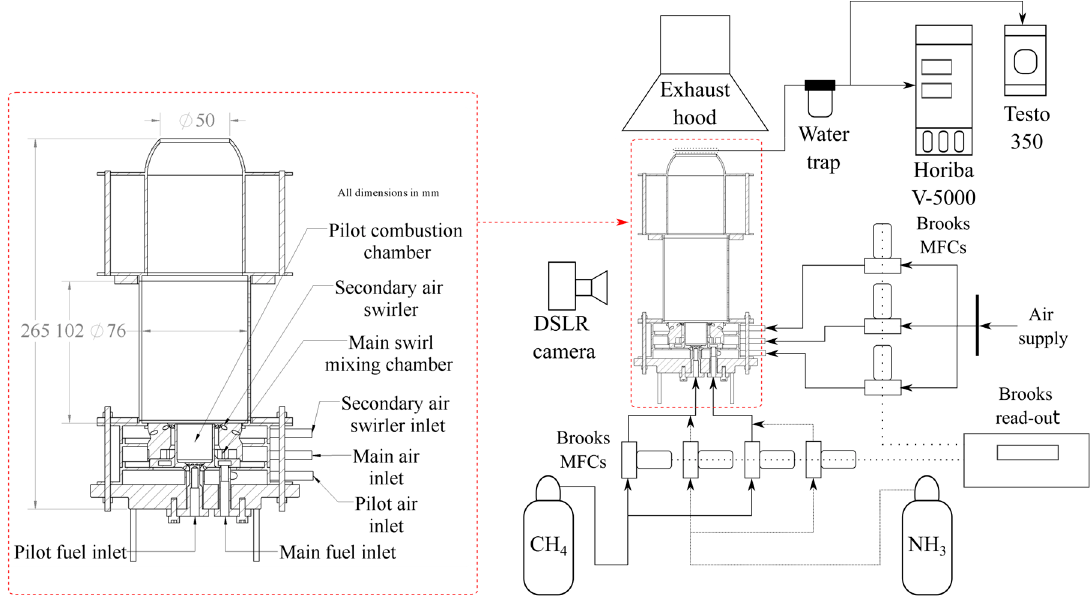
Figure 1. Schematic of the reduced-scale burner and experimental